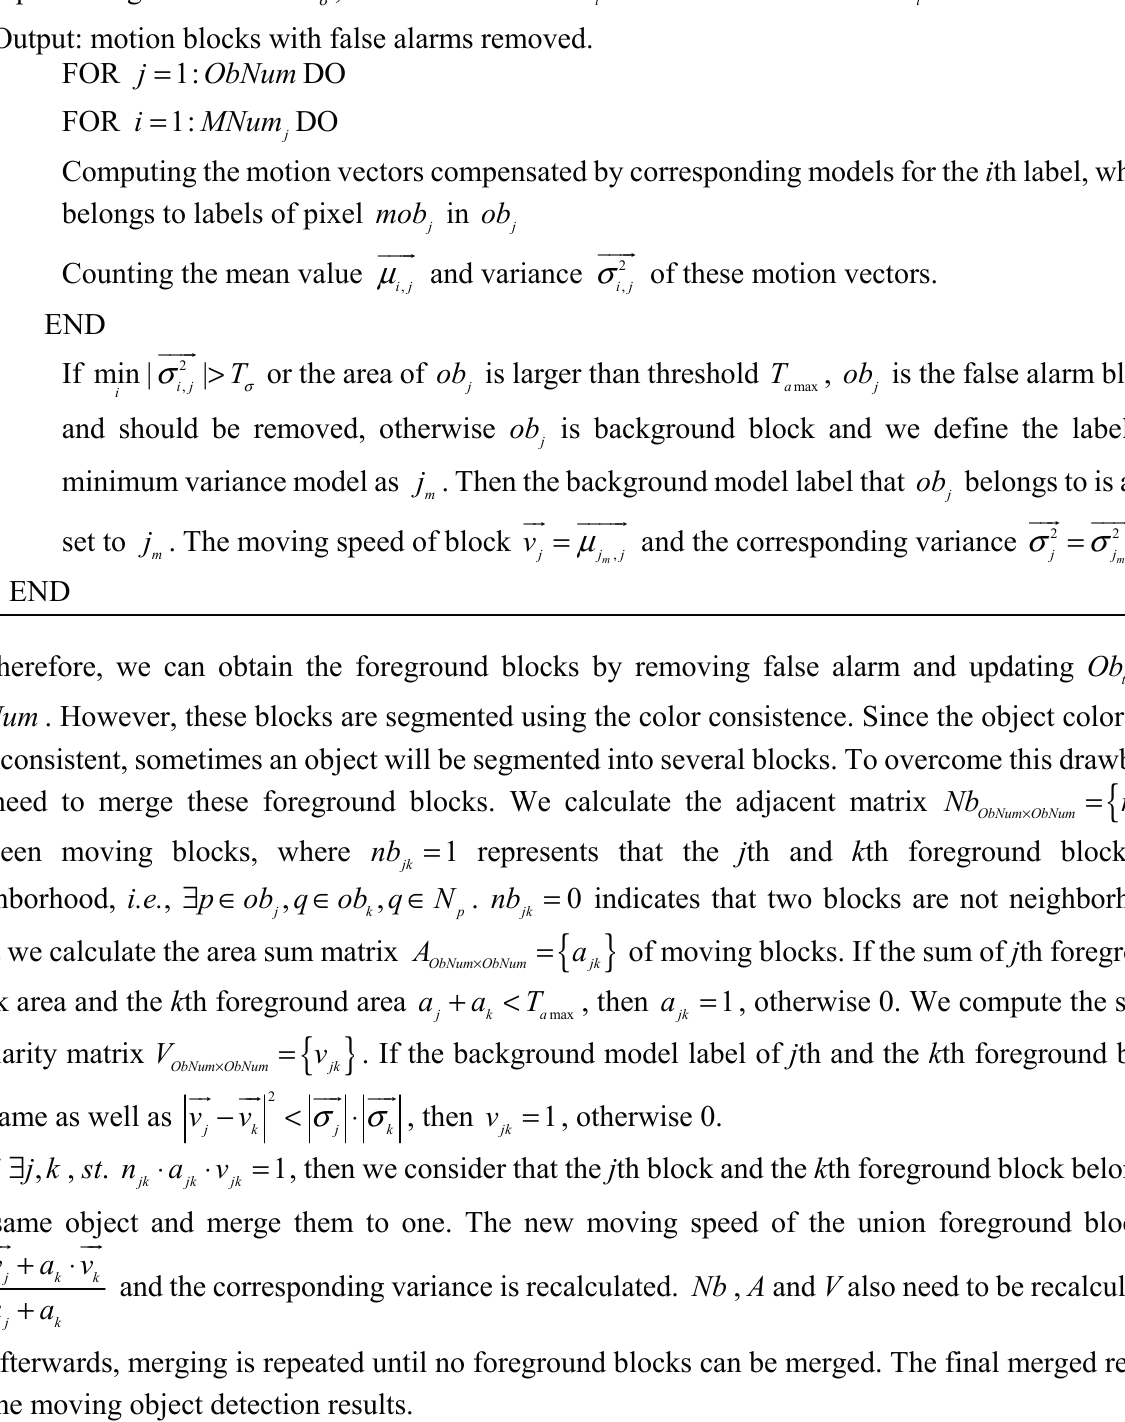
Algorithm 1 False Object Removal